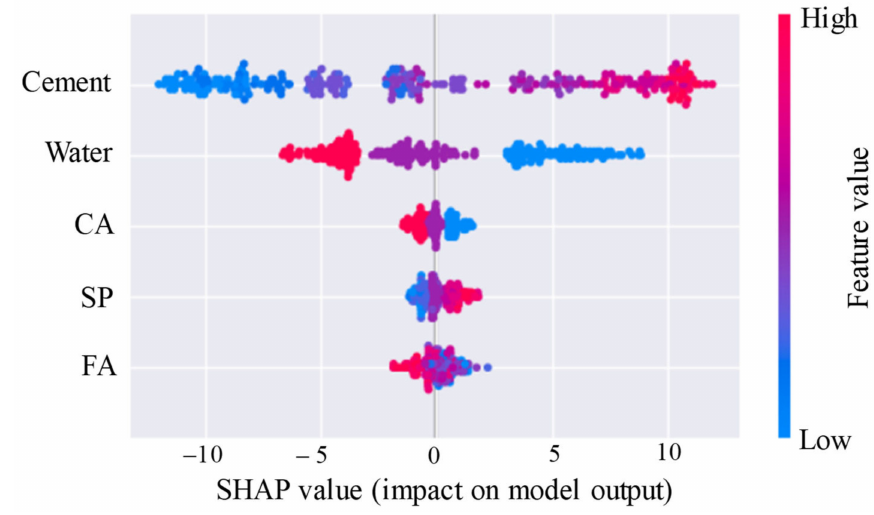
Figure 9. Summary plot for elucidating the global feature influences of the input